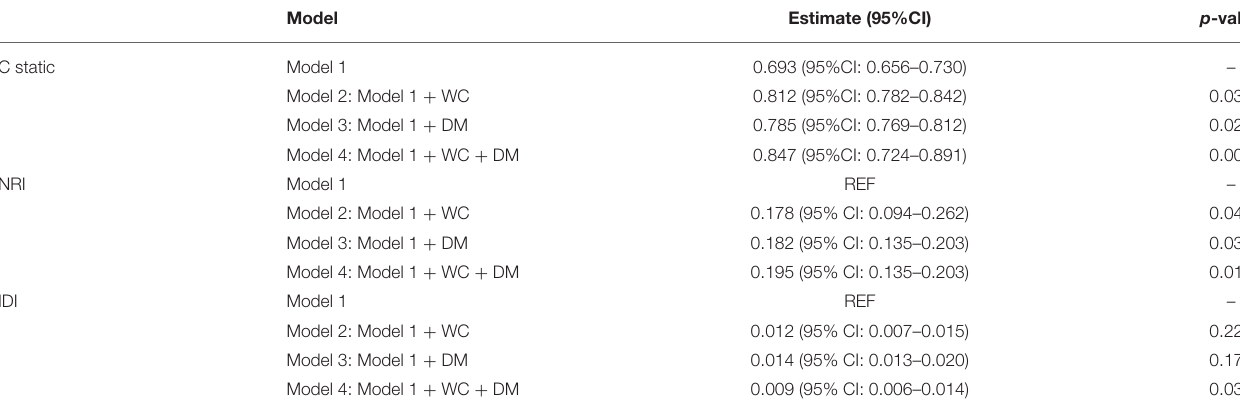
TABLE 3 | Reclassification and discrimination statistics for clinical outcomes by WC level and